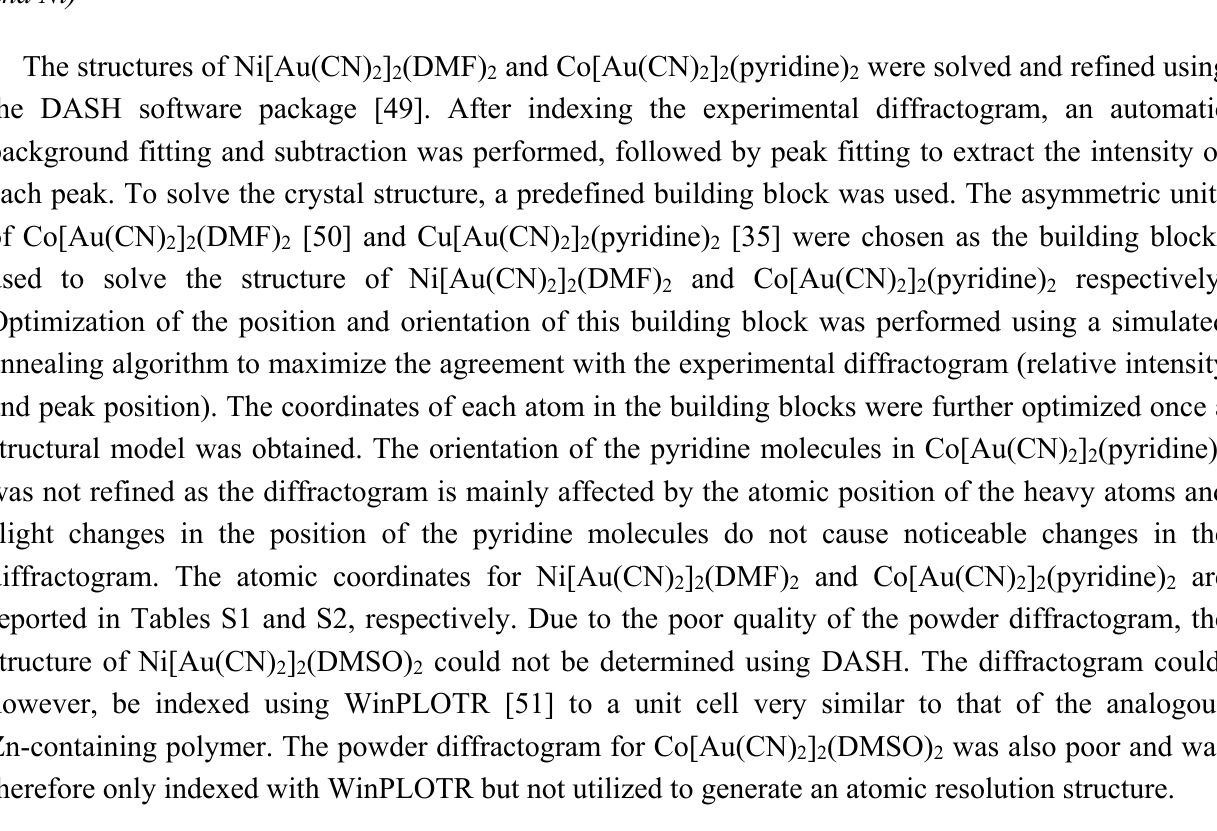
, cm − 1 ) for different M[Au(CN) CN